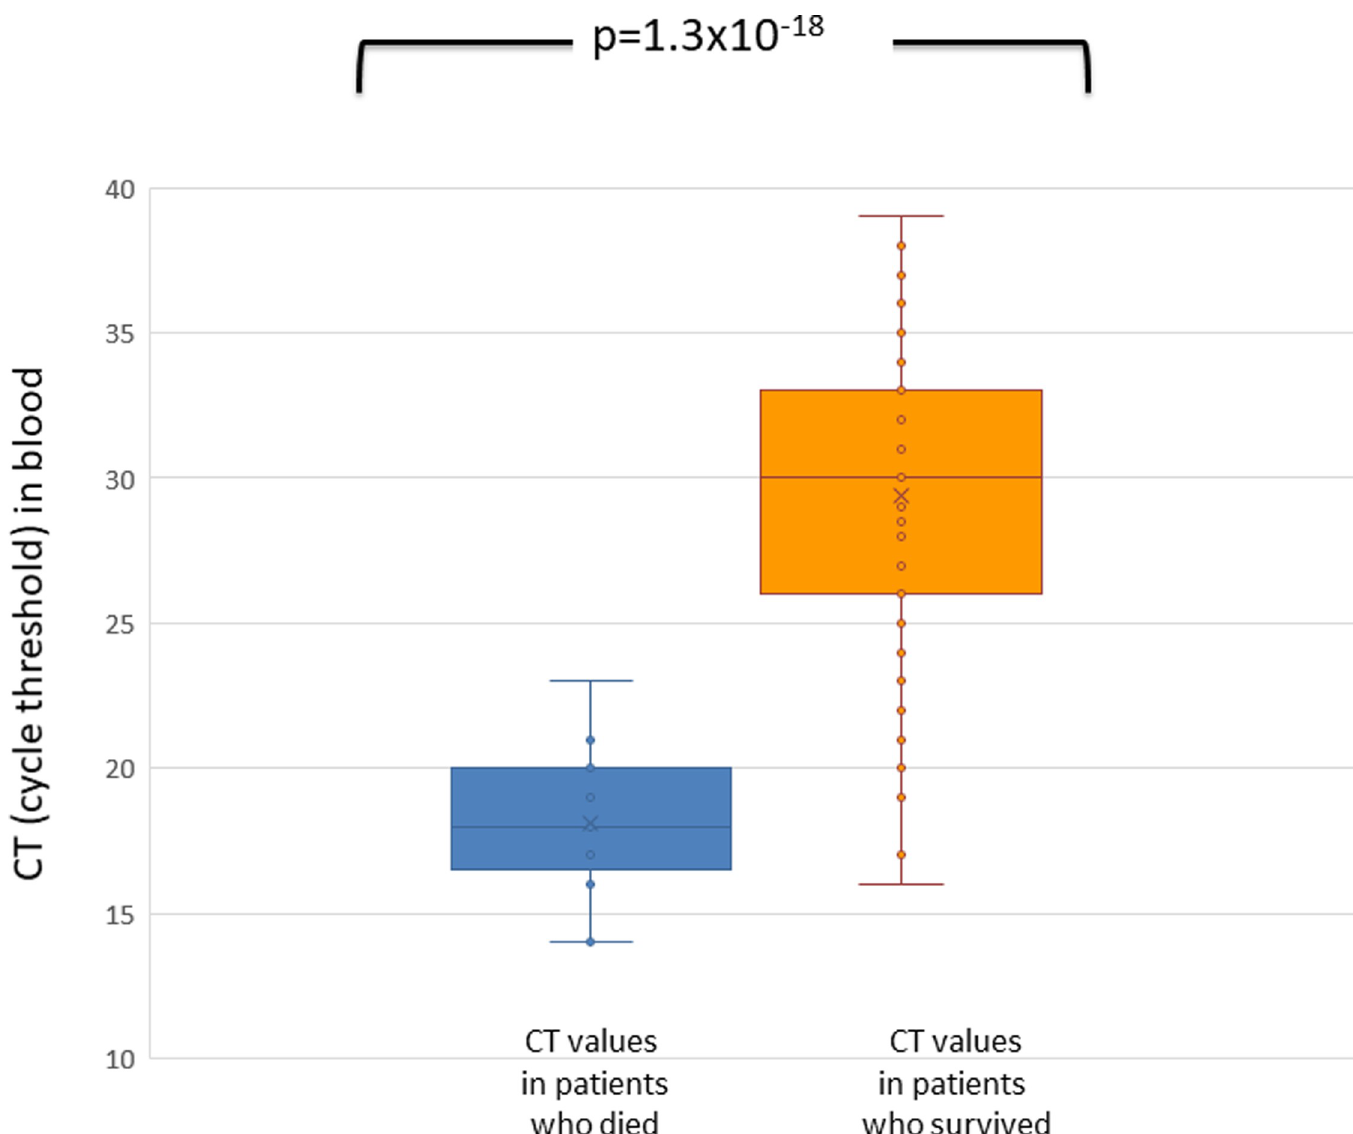
Fig 3. Cycle threshold in blood of patients with invasive meningococcal disease who died (blue) or survived the disease (orange). Cycle threshold is inversely proportional to bacterial